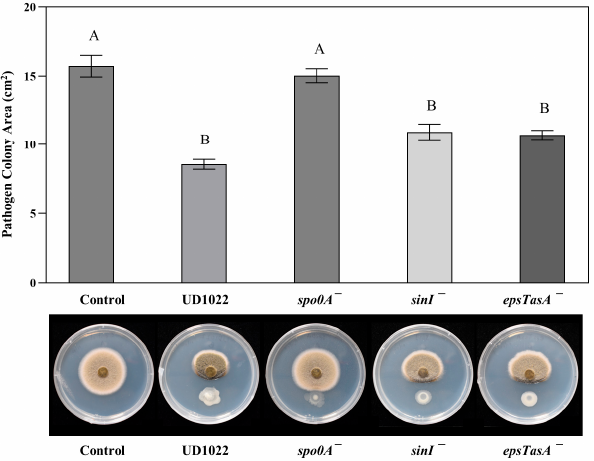
Figure 3. Results of antagonism assays with UD1022 mutants in key biofilm genes against A. medicaginicola StC 306-5. Bars are the mean colony area ( n = 3) and standard error (SE) of the mean from one representative experiment of three experiments performed. The colony area of the spo0A − treatment was not significantly different from the control ( p = 0.881), and biofilm mutant treatments sinI − and eps − - tasA − colony areas were not different from UD1022.